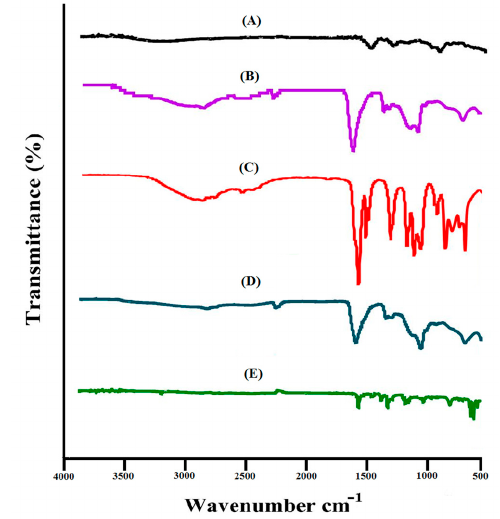
Figure 2. FTIR spectra of ( A ) DS, ( B ) carbopol, ( C ) AA, ( D ) unloaded Car934-g-poly(acrylic